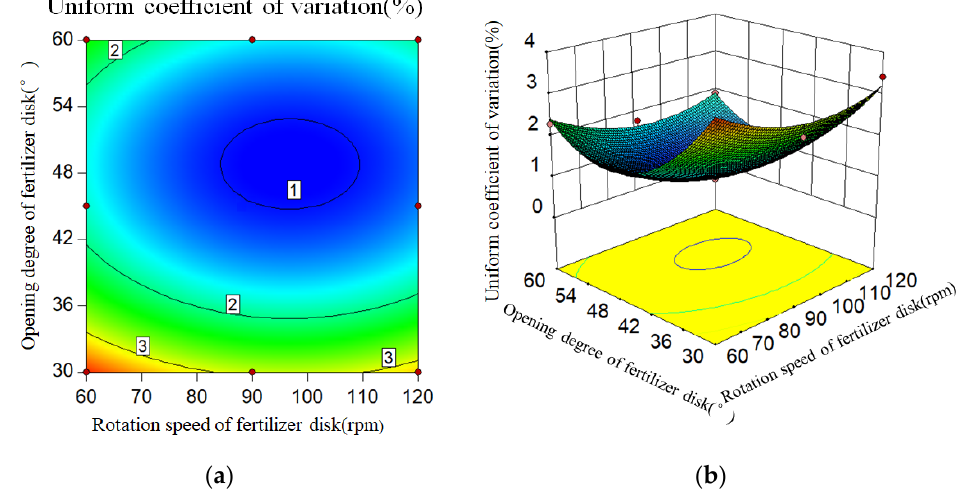
Figure 11. The relationship between the coefficient of uniformity variation and the rotation speed and opening of the fertilizer disk. ( a ) Contour map; ( b ) Response surface.